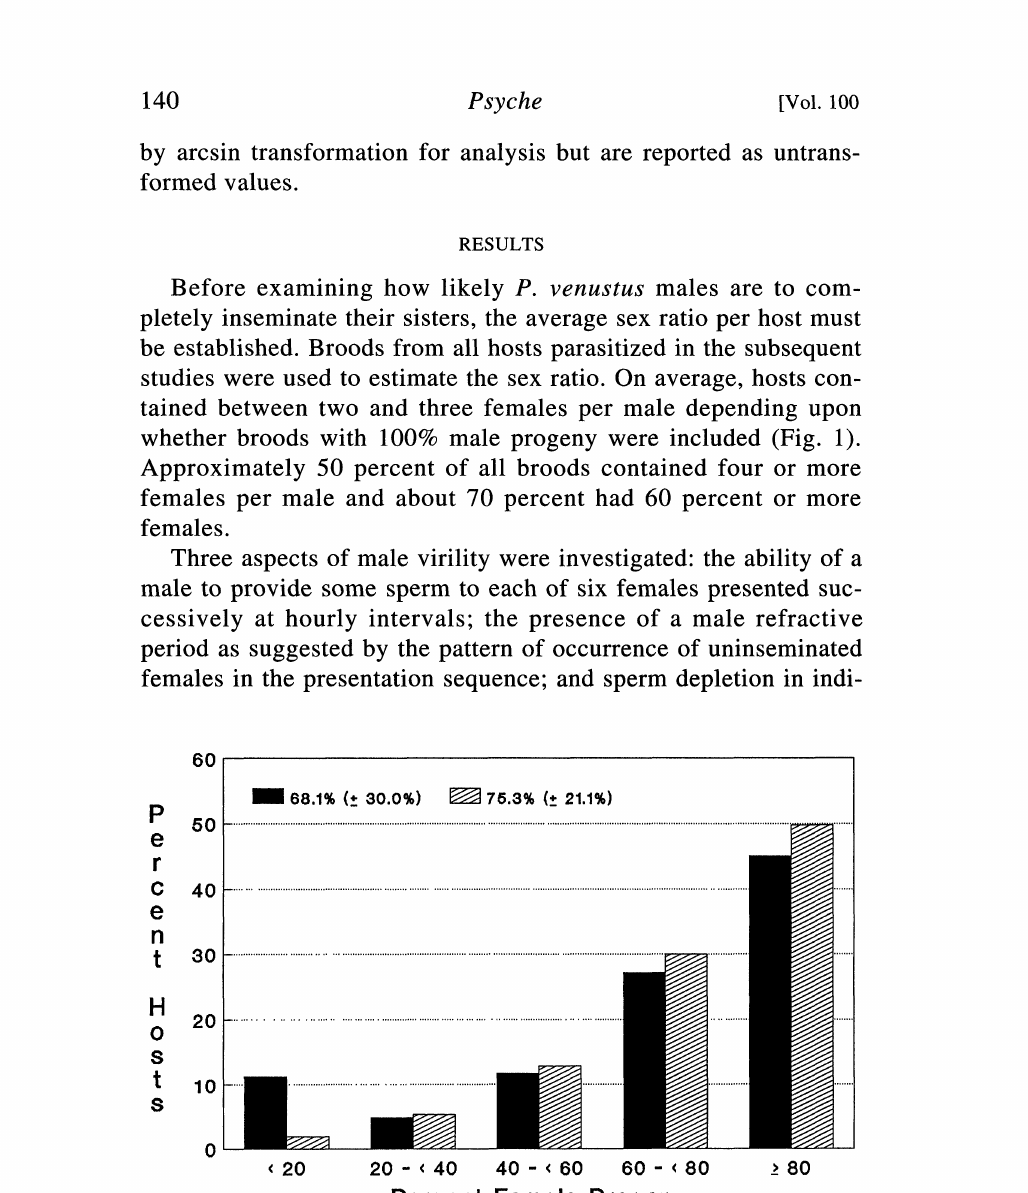
Figure 1. Frequency distribution of hosts by percent female P. venustus they con- tained. Black bars represent all hosts (N 291), hatched bars represent all hosts that contained at least one female (N 263). Means (_+ so) presented for each